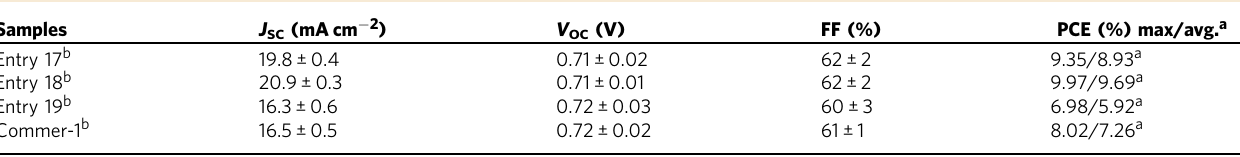
avg. average a The average values were obtained from over 30 devices with the standard deviation b The thicknesses of the polymer blending fi lms with PC 71 BM are 85, 80, 78, and 83nm,